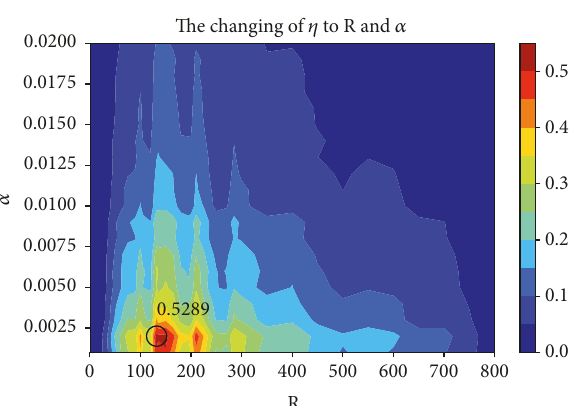
Figure 2: The changing of 𝜂 to 𝑅 and 𝛼 based on CSI300 data in year